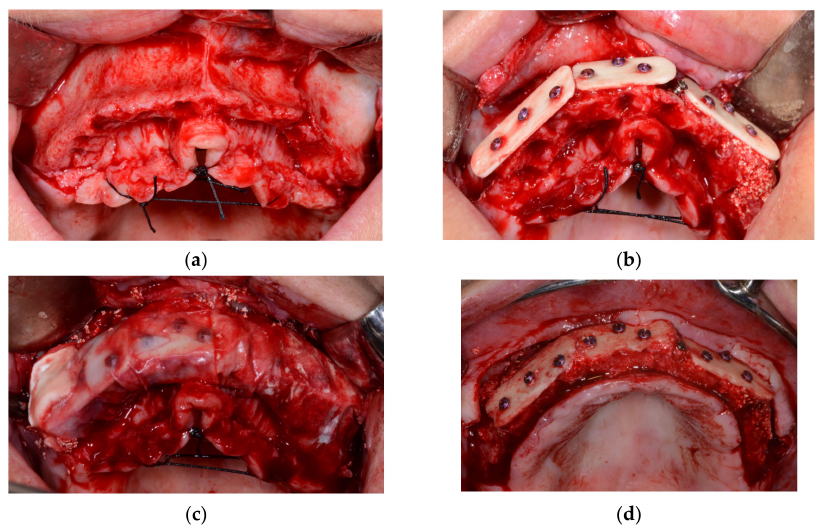
Figure 1. ( a )—Initial situation after flap retraction; ( b )—allogenic cortical lamina fixed in